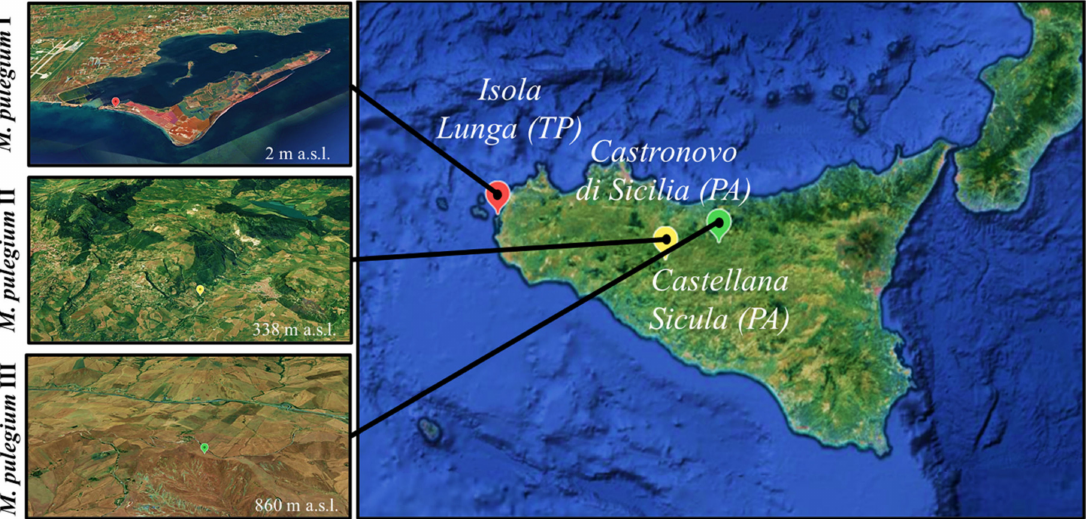
Figure 1. Collection sites identified by Google Earth (https://www.google.it/earth/, accessed data 15 February 2021) using the GPS coordinates.